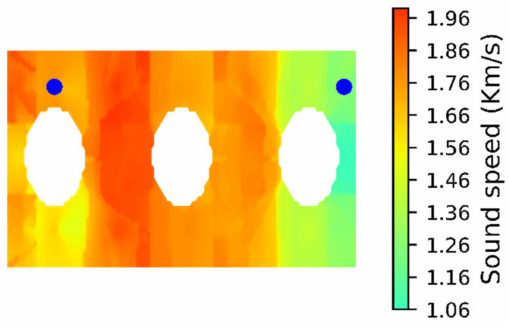
Figure 6. Example of top face interpolation for one industrial pre-baked anode and cored positions indicated by the blue circle. The white circles represent the stub holes, and the color bar is proportional to the interpolated speed of